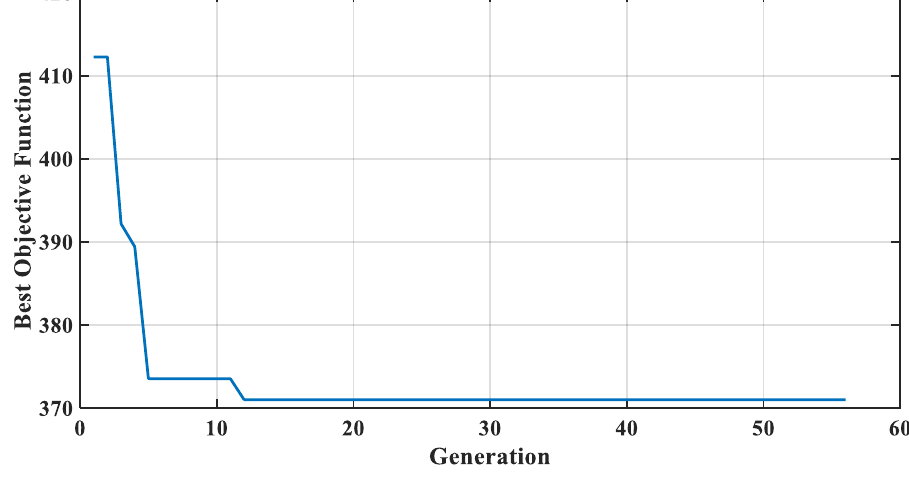
Figure 14. GA evolution.